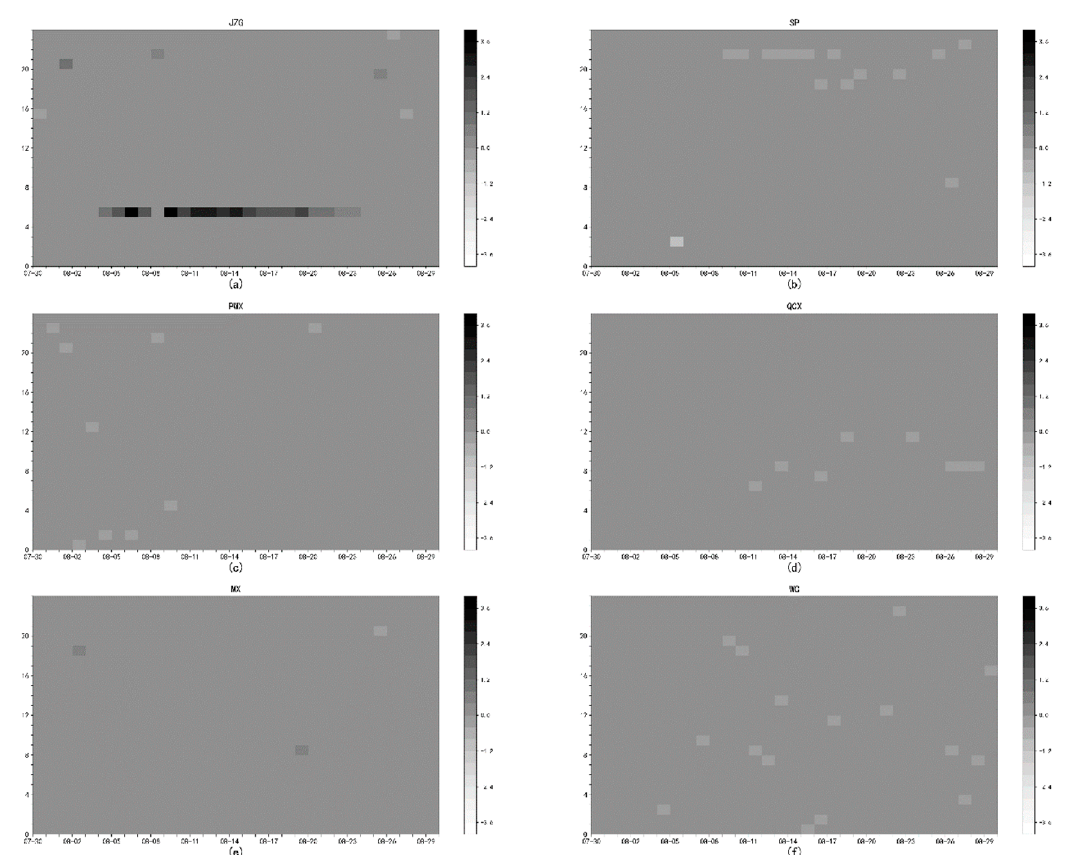
11 Figure 11. Thermogram of abnormal values in stations within 200 km of the Jiuzhaigou epicenter. ( a ) JZG station; ( b ) SP station; ( c ) PWX station; ( d ) QCX station; ( e ) MX station; ( f ) WC